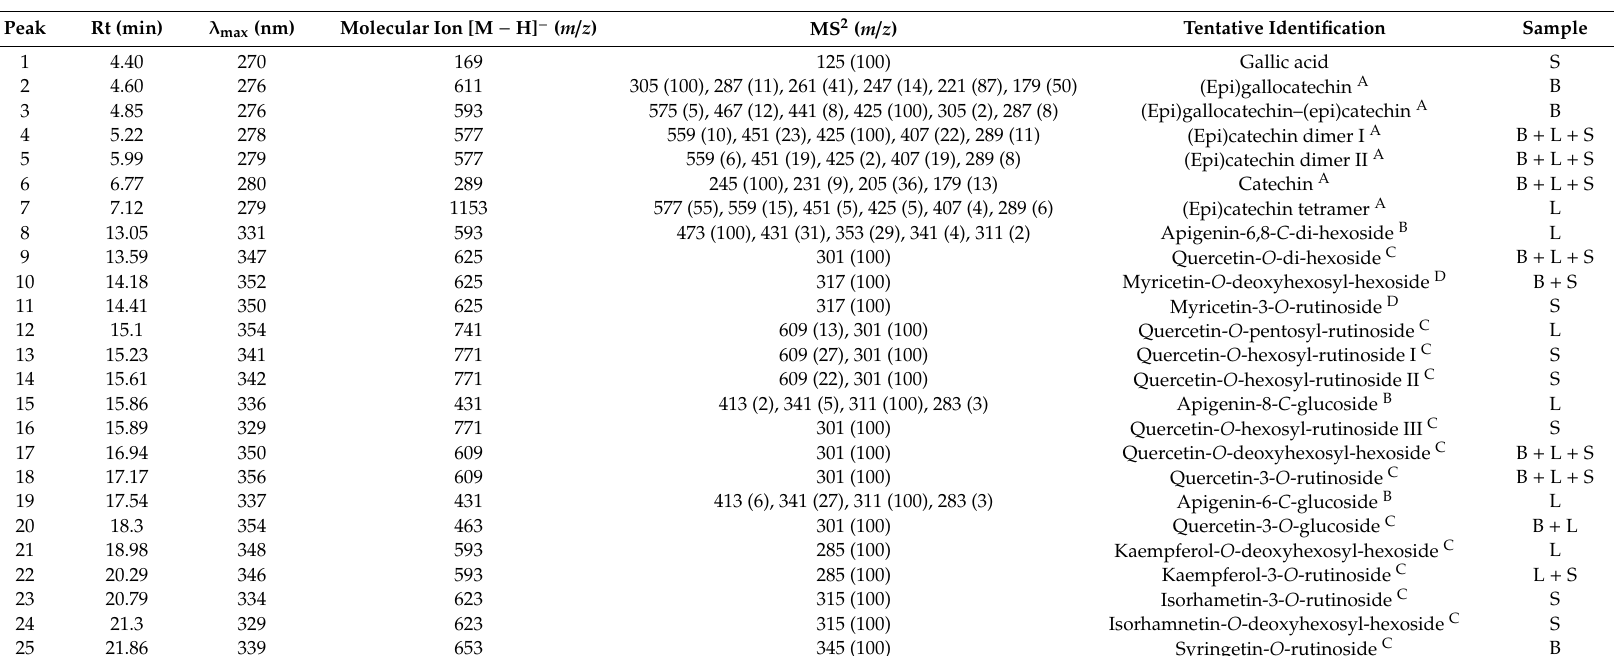
Table 1. Retention time (Rt), wavelengths of maximum absorption in the visible region ( λ max ), mass spectral data, and tentative identification of the phenolic compounds present in C. urucurana Baill. leaves (L), branches (B), and bark (S). Peak Rt (min) λ max (nm) Molecular Ion [M − H] − ( m / z ) MS 2 ( m / z ) Tentative Identification